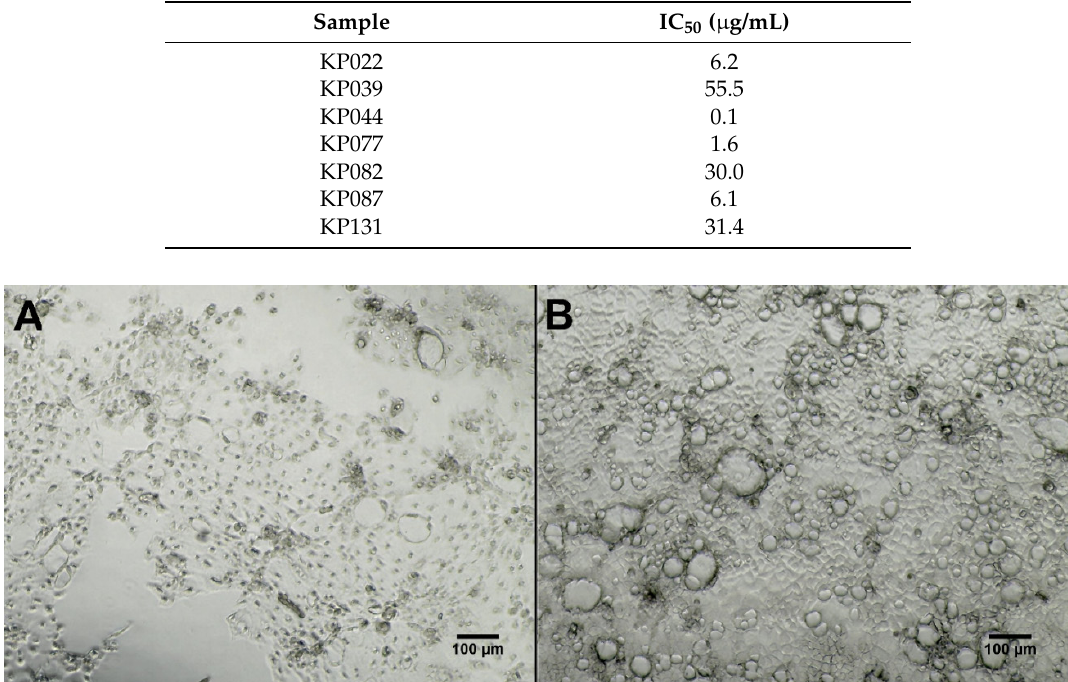
Figure 7. Micrographs (taken with EVOS XL Core Imaging system, 100× magnification in phase contrast) of Caco-2 cells seeded in 96 microplate wells after 48 h of exposure to metabolite extract of strain KP087 ( A ) at 10 µg/mL (viability test showed 37 % viability for this well) and medium blank ( B ) at 10 µg/mL (viability test showed 100 % viability for this well). Formation of apoptotic bodies can be seen in ( A ) as small black dots, as well as areas free of cells in the lower part of the picture as cells could no longer attach to plate. Cells exposed to medium blank ( B ) show full confluence where single cells cannot be distinguished.